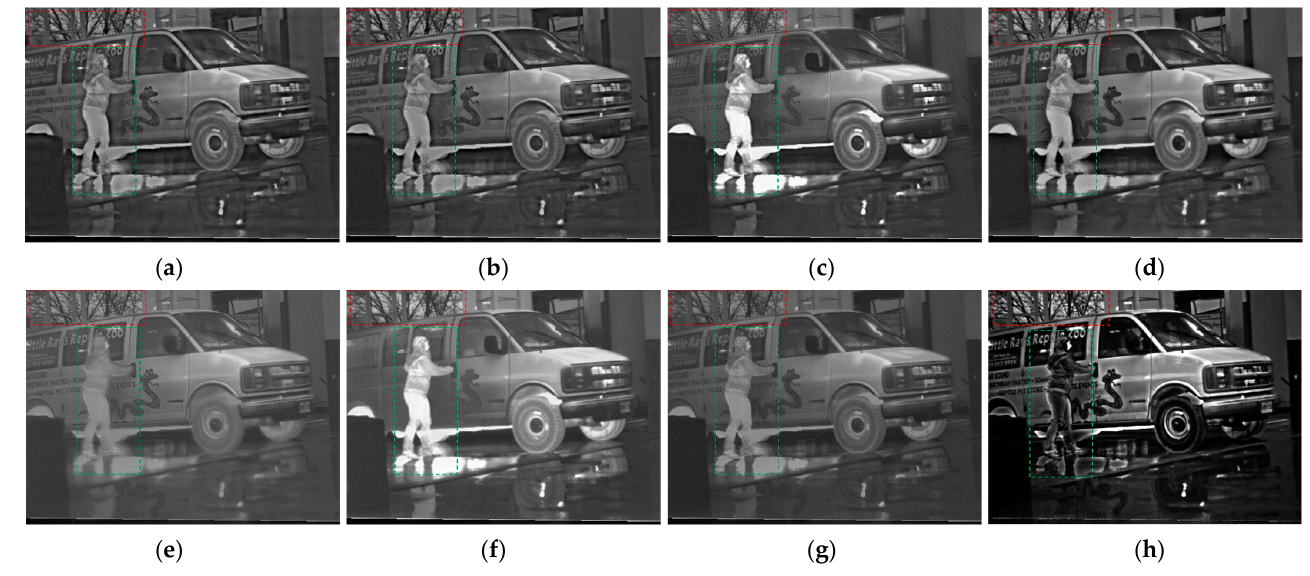
Figure 10. Performance comparison of different fusion methods on the image pair “Car”. ( a – h ) are the results of CVT, CWT, WLS, LP, ADF, GTF, MSVD and our algorithm, respectively.